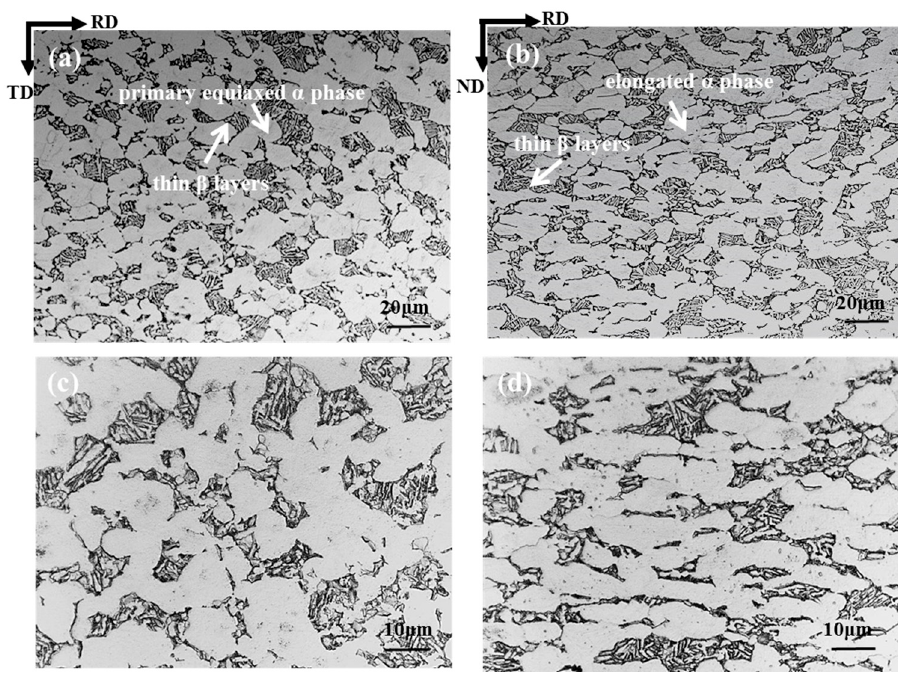
Figure 4. The initial microstructure of the TA31 cylindrical shell in different positions: ( a , c ) RD-TD plane; ( b , d ) RD-ND plane.